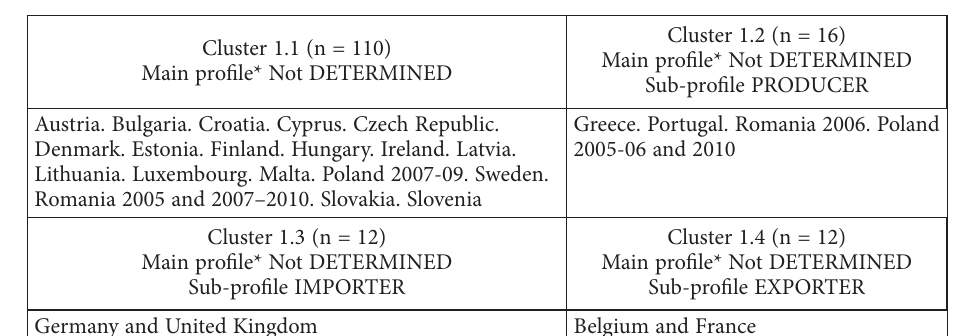
Table 7. Characterization of the conglomerates of the second level of the pre-crisis chained cluster (source: own elaboration based on COMTRADE,